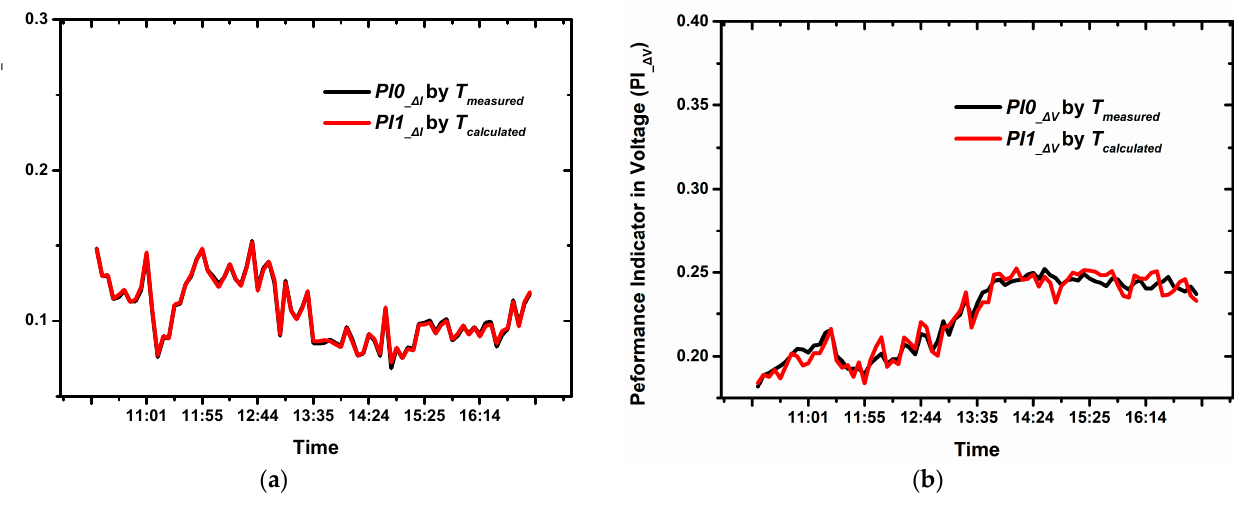
Figure 11. Performance indicators of faultless operation: ( a ) performance indicator in current; ( b ) performance indicator in voltage.